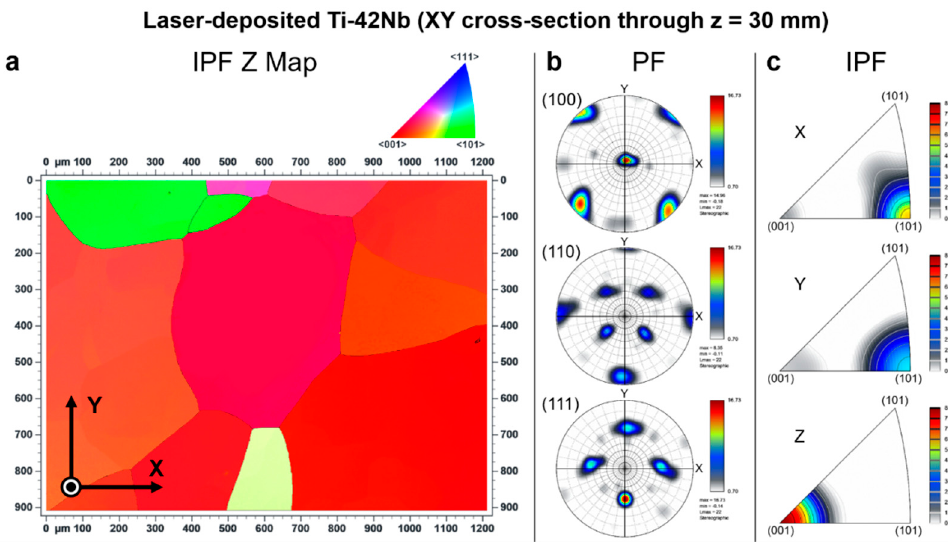
Figure 9. Electron backscatter diffraction (EBSD) results at XY cross-section through z = 30 mm: ( a ) inverse pole figure Z map (IPF Z Map), ( b ) pole figures (PF), and ( c ) inverse pole figures (IPF).